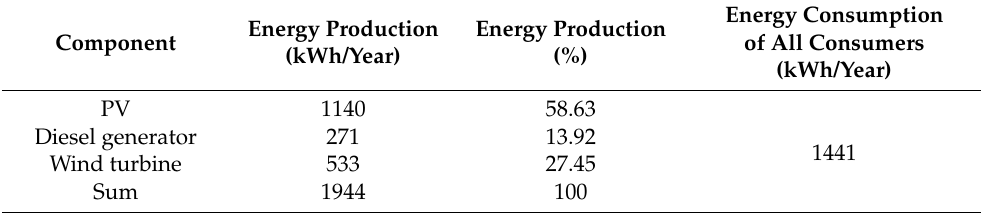
Table 4. The annual production of each component.